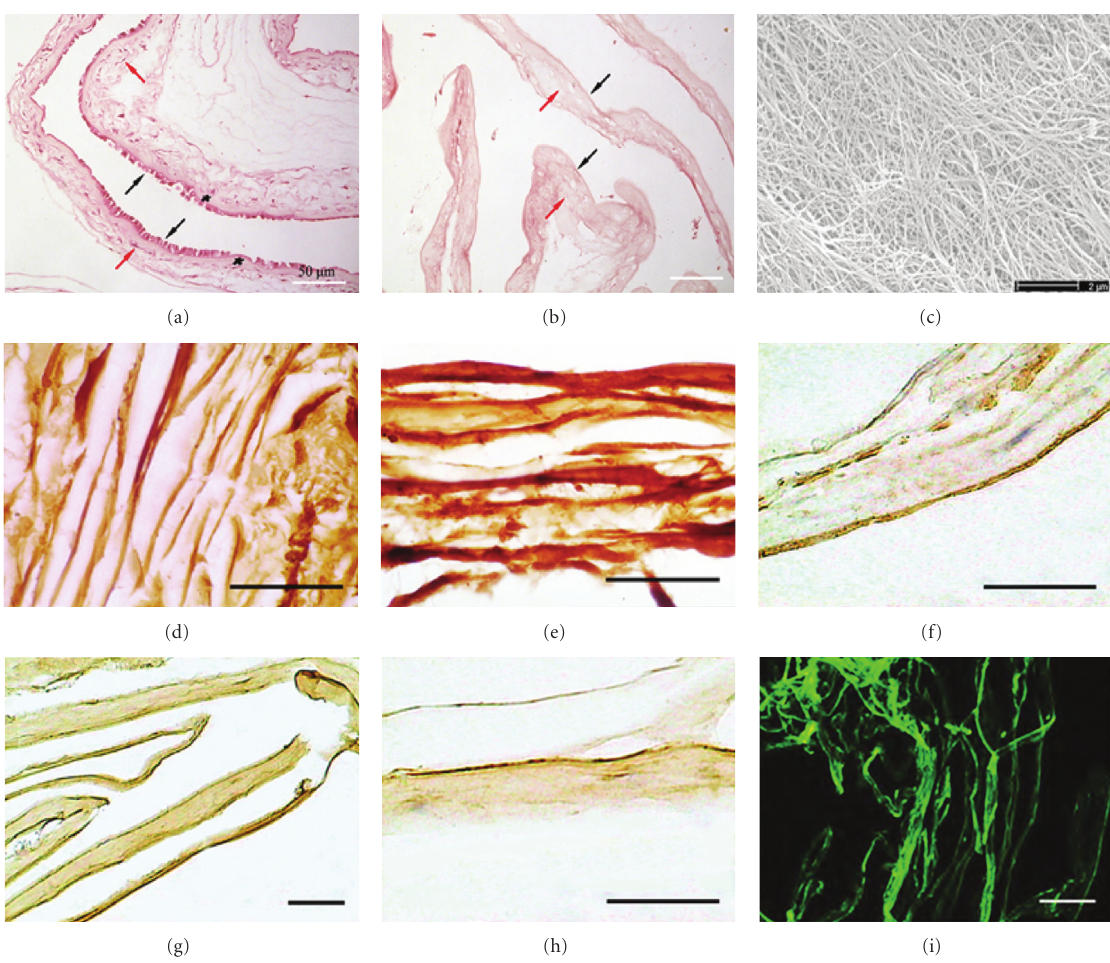
Figure 1: Histology of the HAM and AHAM. (a) The HAM was composed of five layers as shown by HE staining. Black arrows indicate the epithelial layer, asterisk indicates the basement membrane, and red arrows indicate the avascular stroma layer. (b) The epithelial layer and fibroblasts in the stromal side were thoroughly removed for the AHAM. Black and red arrows indicate the basement membrane and stromal layer, respectively. Scale bar, 50 μ m. (c) SEM image of the AHAM. The stromal layer was reticular and composed of collagen fibers with various diameters. There was no residual cell debris. Scale bar, 2 μ m. (d) Type I collagen, (e) type III collagen, (f) type IV collagen, (g) fibronectin, and (h) laminin were positive in immunohistochemistry staining. (i) Type VI collagen was positive in immunofluorescence staining. Scale bar, 50 μ